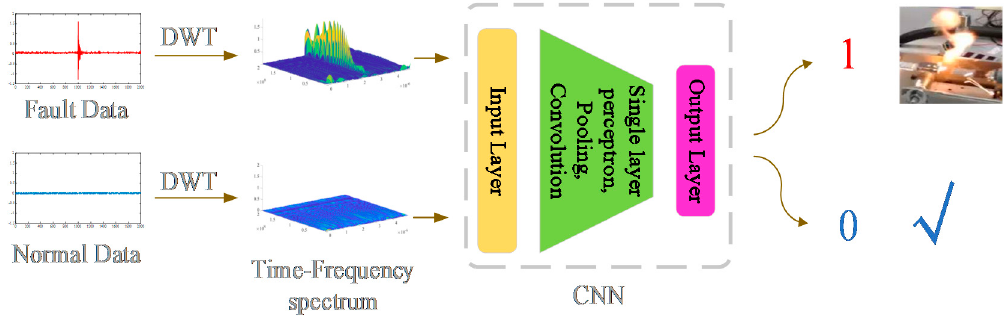
Figure 6. The flow chart of the algorithm.